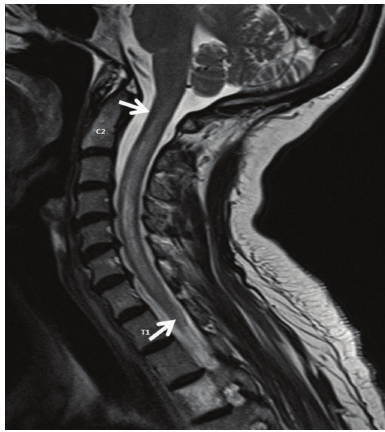
Figure 1: Chest X-ray showing hypoinflated lung fields, with basal atelectasis and elevated hemidiaphragms.